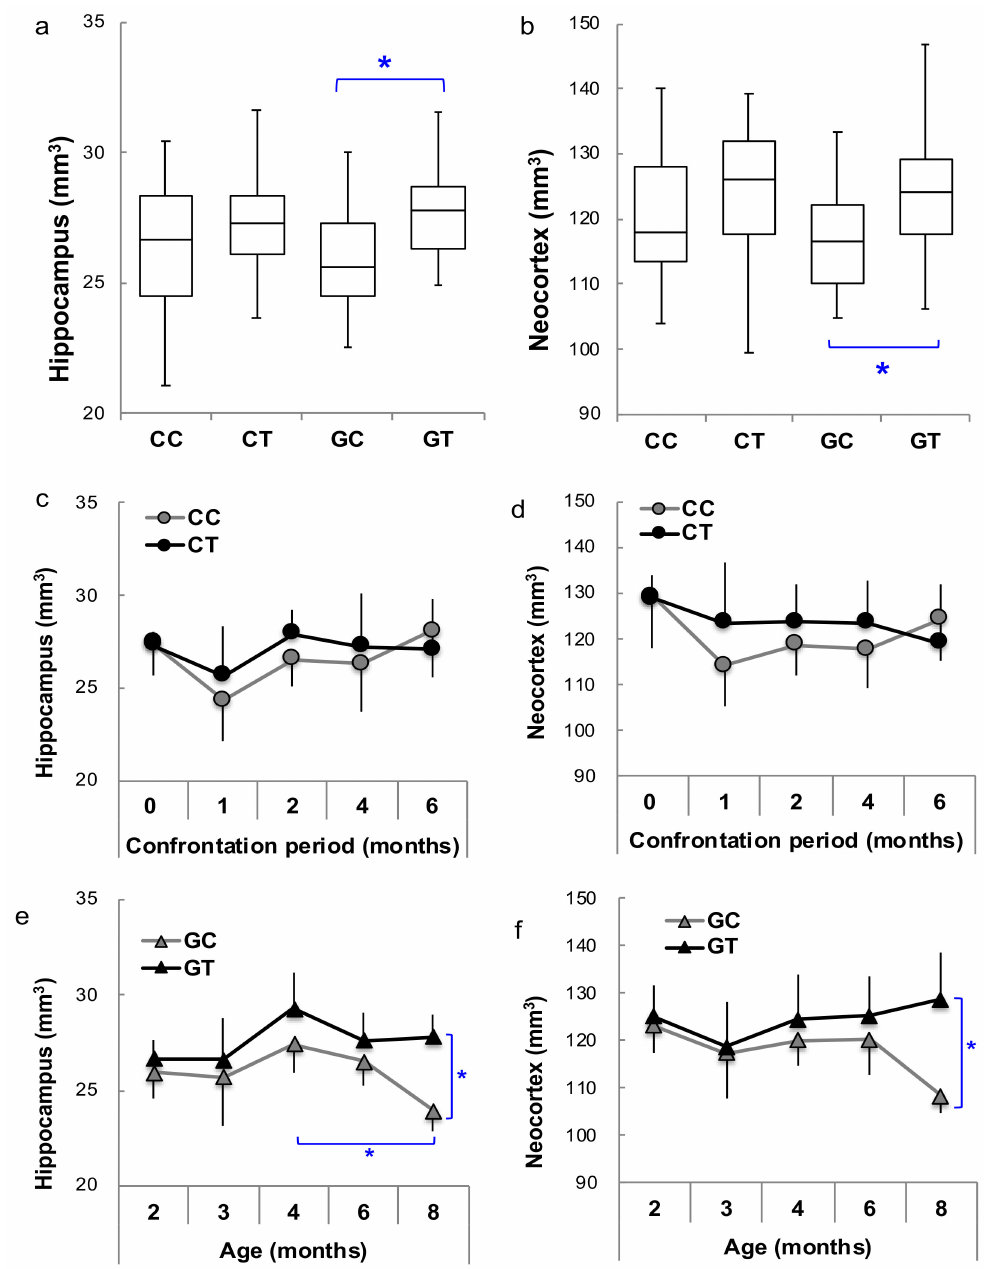
Figure 4. The brain volumes of ddY mice. Boxplot of the volumes of brain sections in the hippocampus ( a )andneocortex( b )werecomparedamongthefourgroups(CC,CT,GCandGT)withoutdistinguishing age ( n = 115, *; p < 0.05). The time-course of the hippocampus and neocortex were compared between CC and CT ( c , d ) and between GC and GT ( e , f ) ( n = 4–6; *, p <